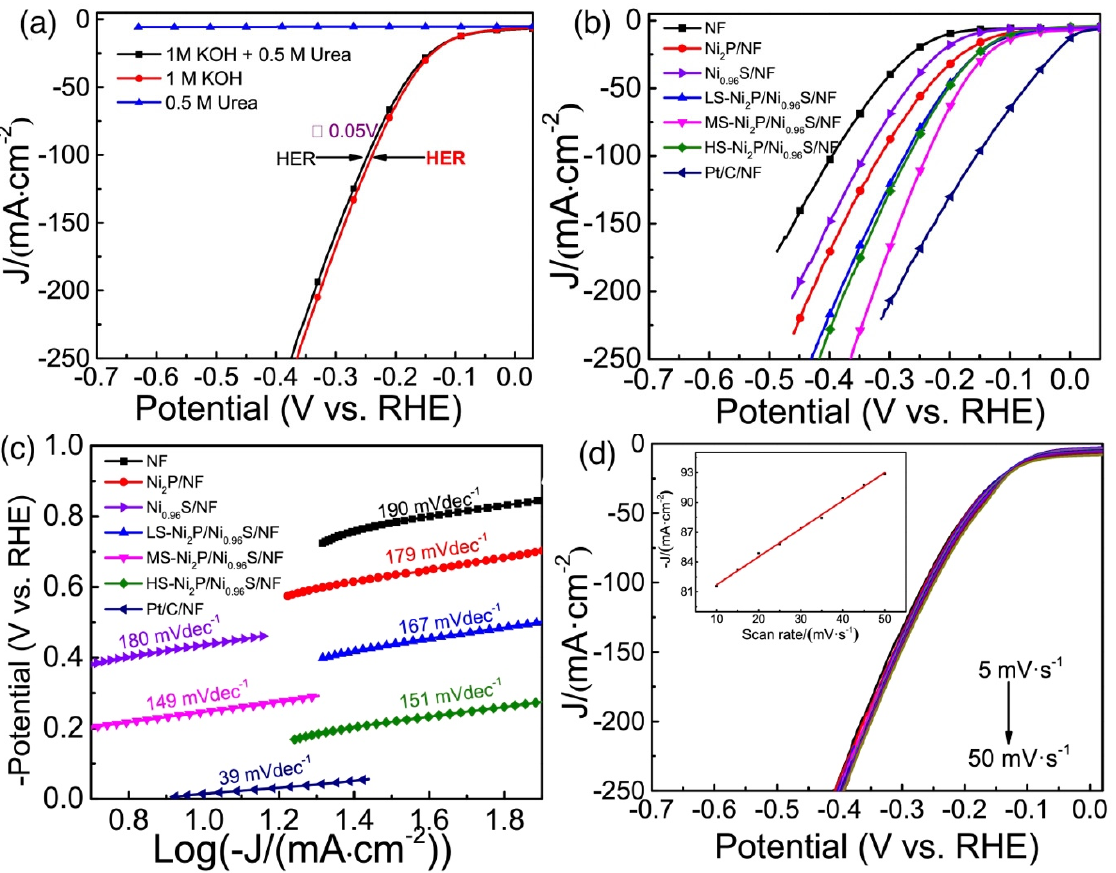
Figure 21. ( a ) LSV curves of MS-Ni 2 P/Ni 0.96 S/NF, ( b ) LSV curves in 0.1 M KOH with 0.5 M urea, ( c ) Tafel plots and ( d ) LSV curves of MS-Ni 2 P/Ni 0.96 S/NF at different scan rates. Reprinted with permission from Refs. [97,98].